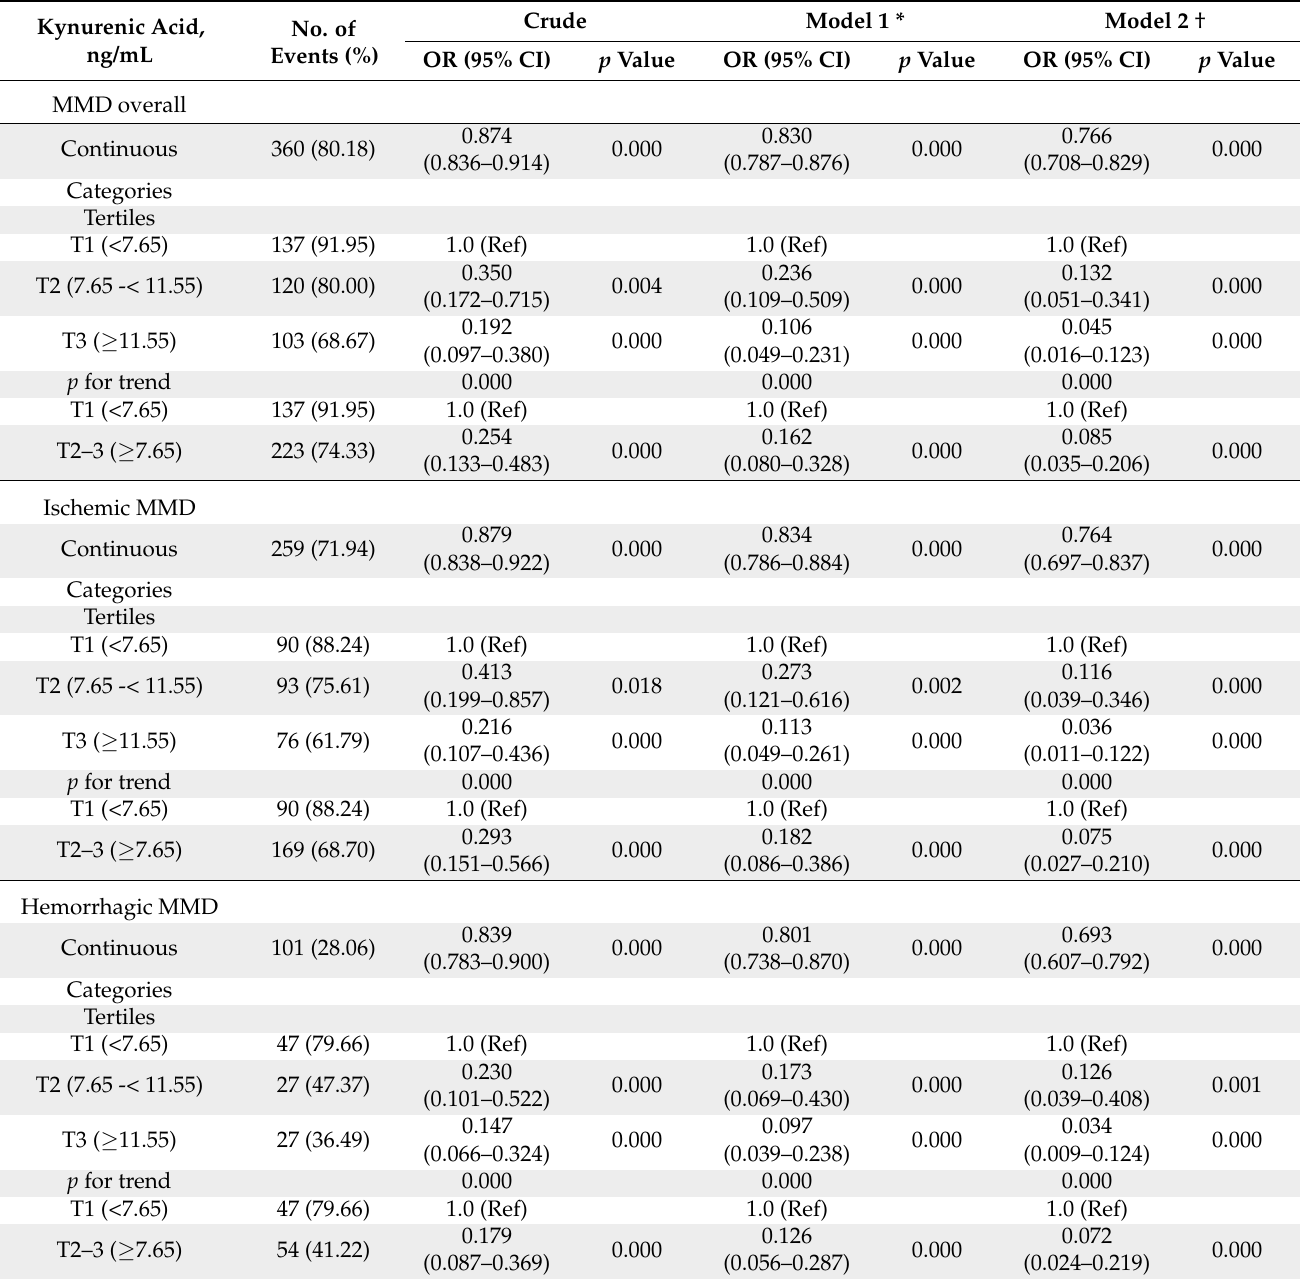
Table 4. The association between kynurenic acid and the risk of